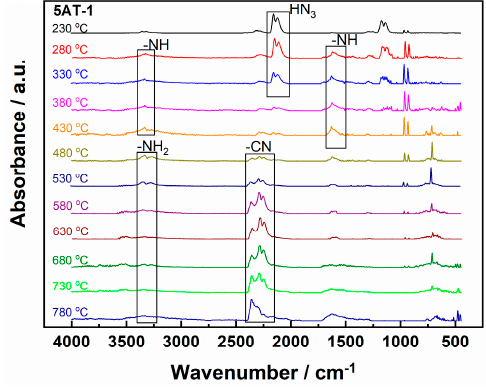
Figure 11. The IR spectrum of 5AT–1.